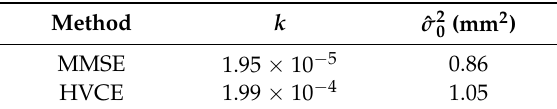
estimated by MMSE and 0